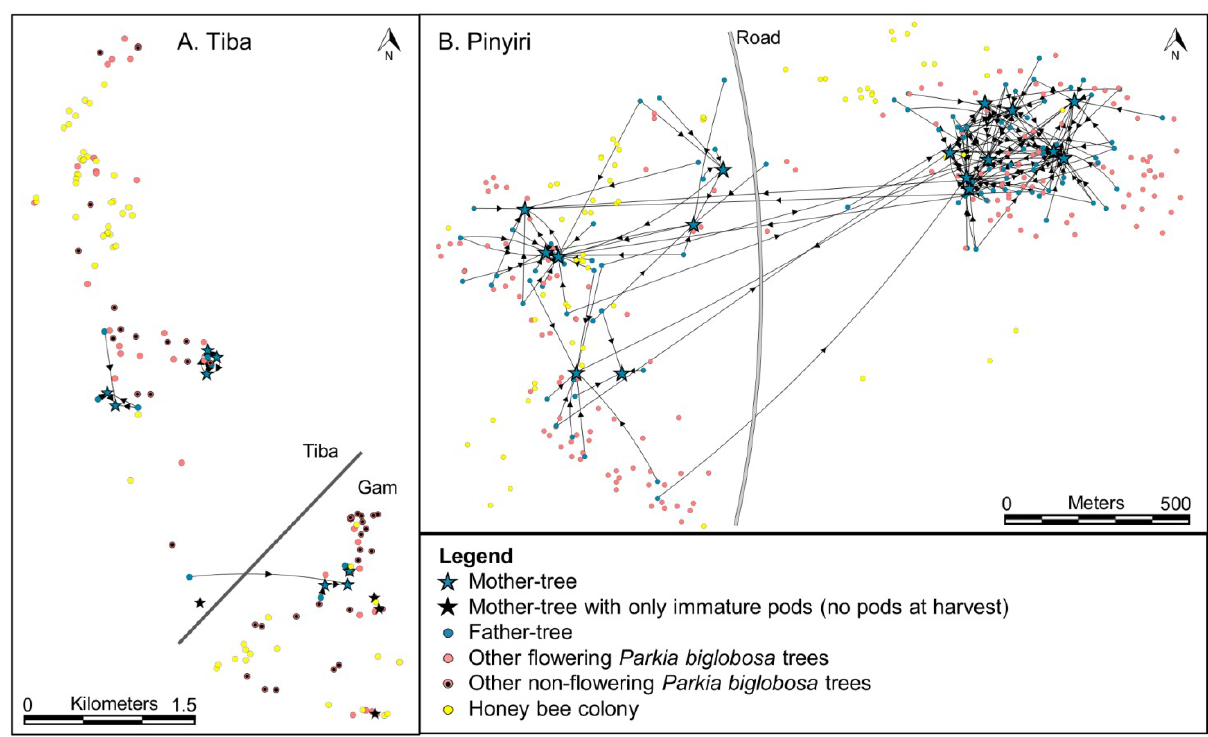
F IGURE 3. Illustration of the cross-pollination events for Parkia biglobosa across treatments (A, Tiba (drier site, also showing Gam); B, Pinyiri (more humid site)). The arrows show the direction of the pollen transport. One arrow may represent more than one pod. Events of self-pollination are not